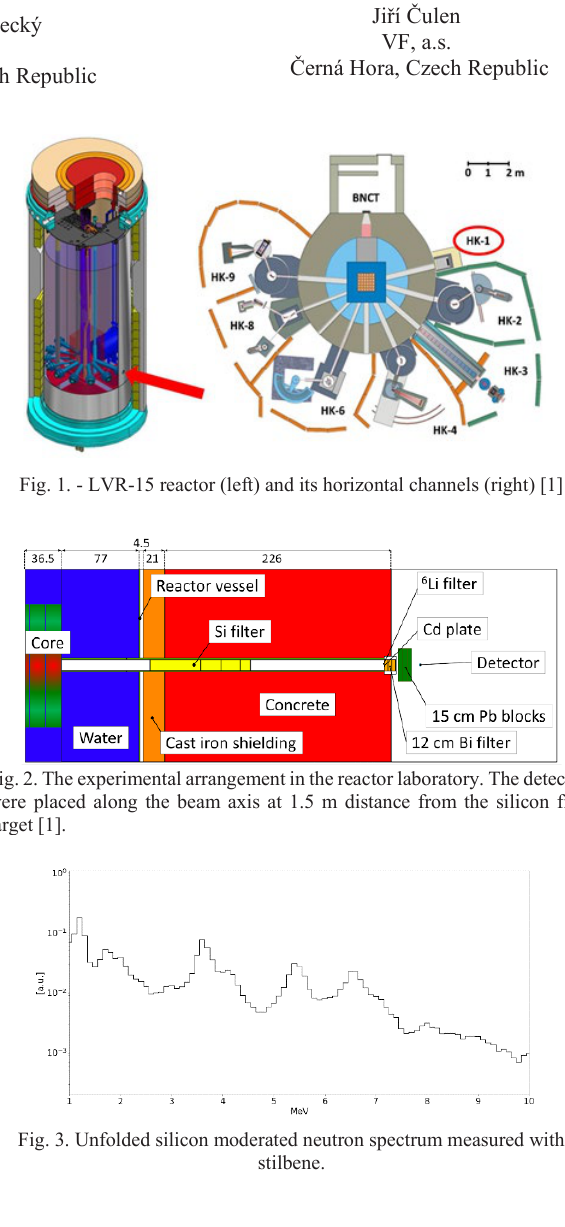
Integration method based on the pulse charge